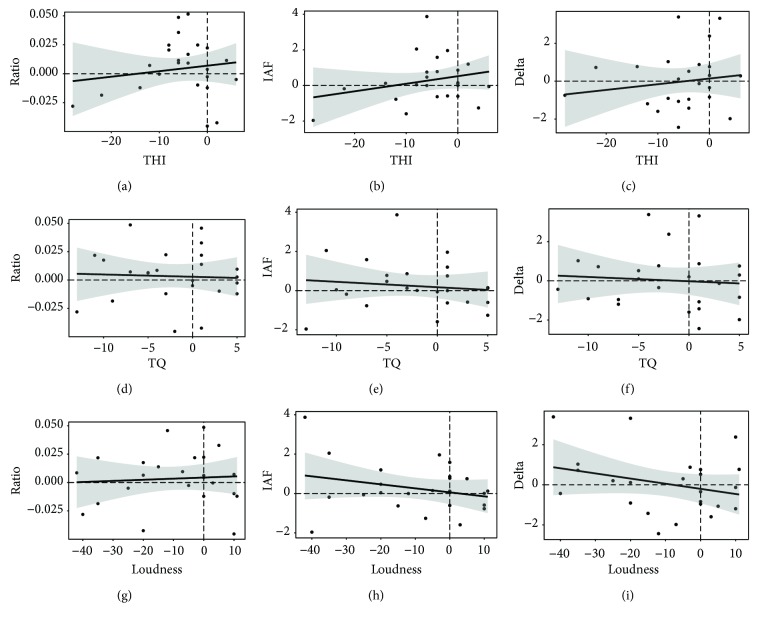
Scatterplots of difference scores (t2-t1) of EEG-NT resting-state data ((a, d, g) alpha/delta ratio; (b, e, h) rewarded individual alpha band power; (c, f, i) inhibited delta band power) and tinnitus-related symptoms ((a–c) THI; (d–f) TQ; (g–i) tinnitus loudness). The plots show the fitted regression lines with 95% confidence intervals. No correlations were found to be statistically significant.